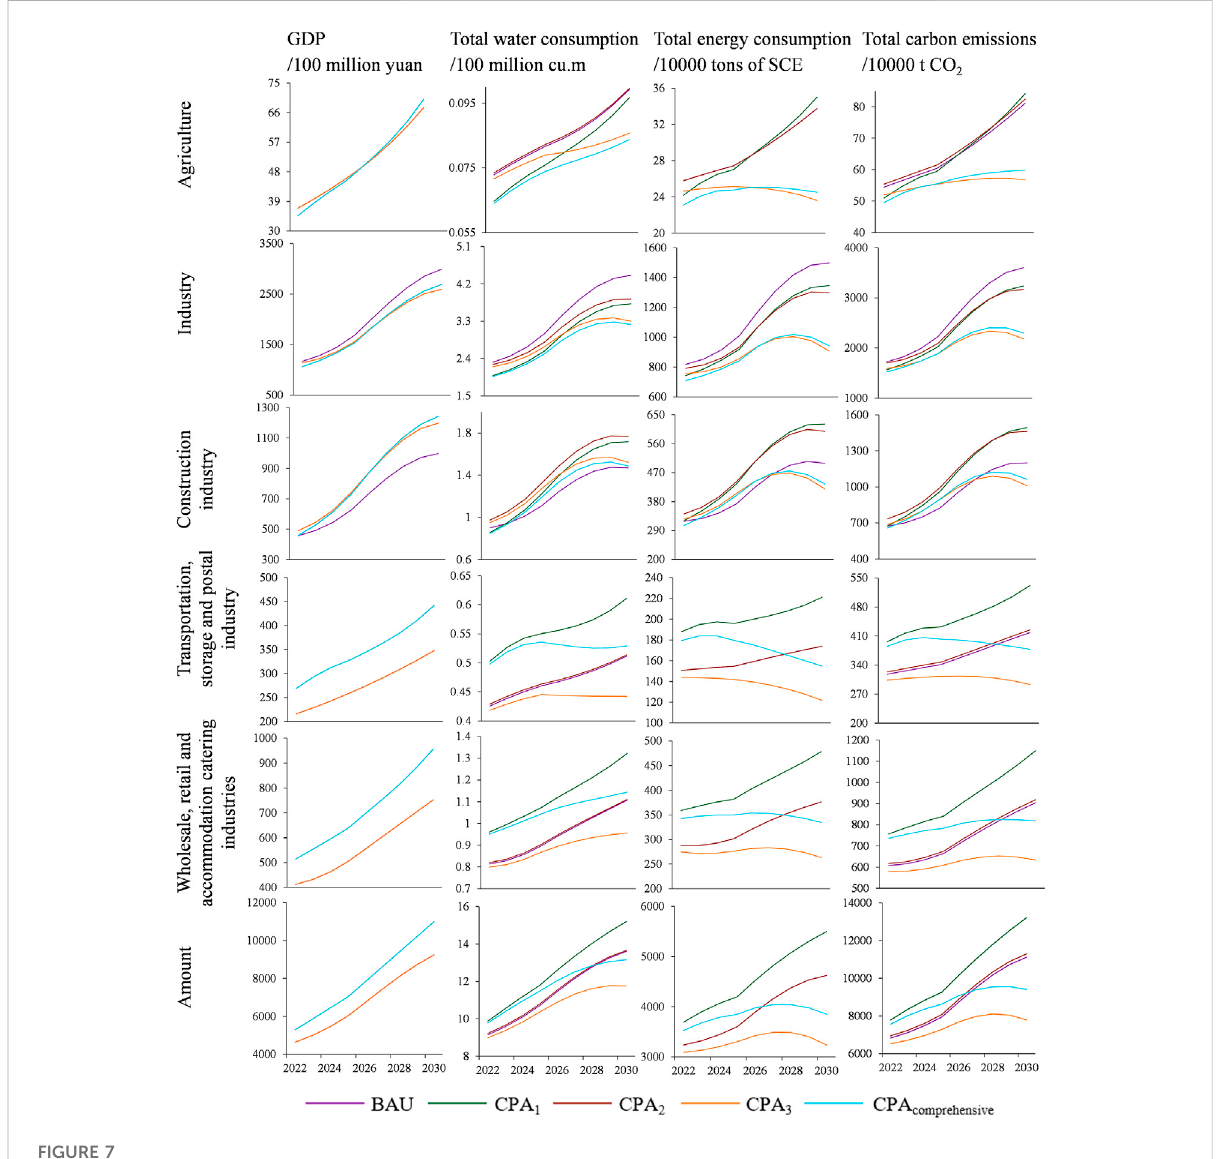
FIGURE 7 Comparison of the simulation results in different scenarios from 2022 to